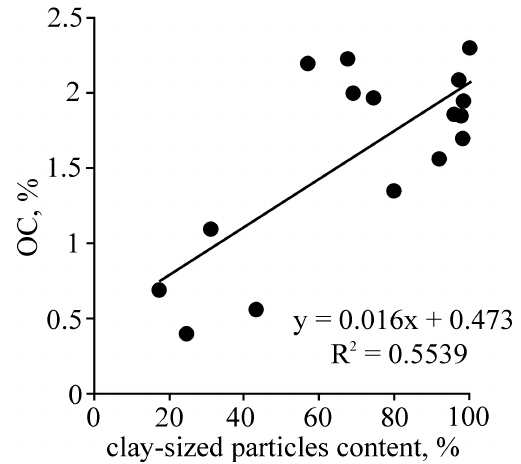
Fig. 7. Correlations between clay-sized particles content (%) and OC content in bottom sediments (%) for year